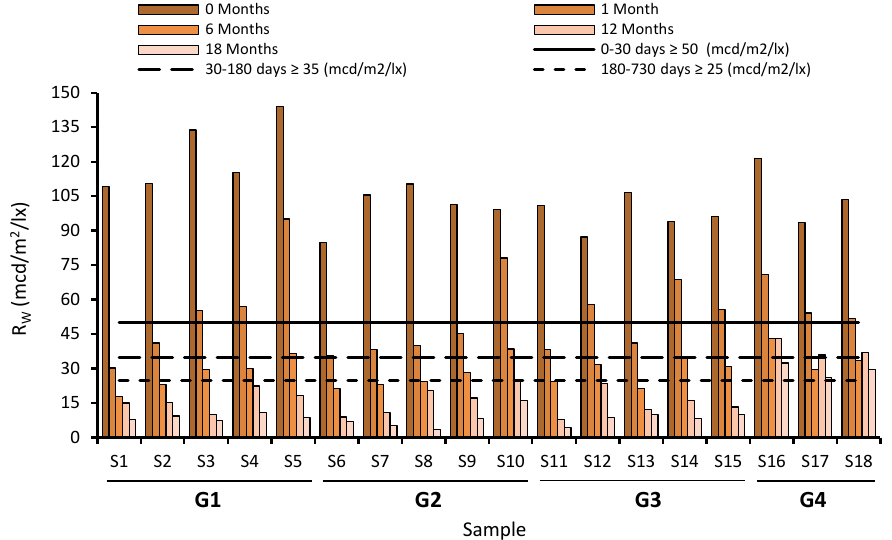
Figure 14. Evolution of R W on test samples during the first 18 months of service.